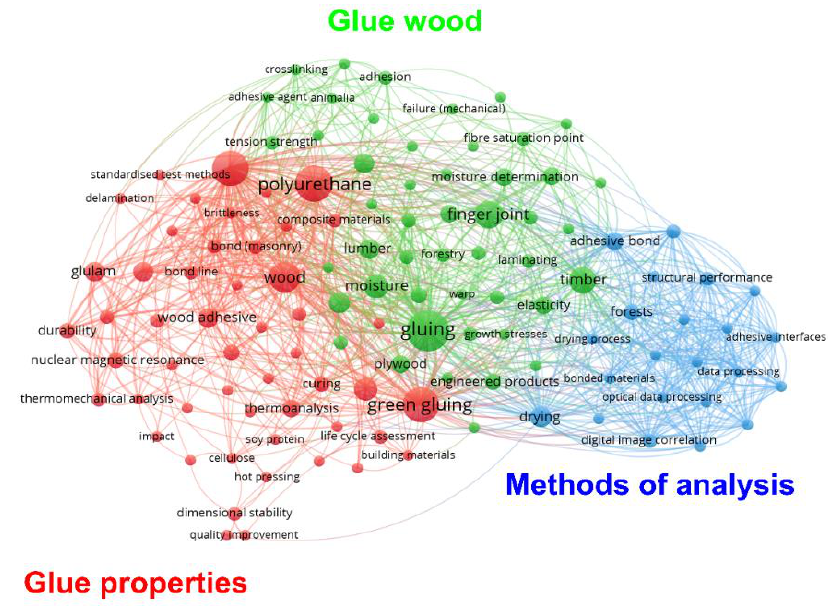
Figure 2. Bibliometric map of keywords consigned in papers on “Green Glued” in network visualization (VOSviewer).